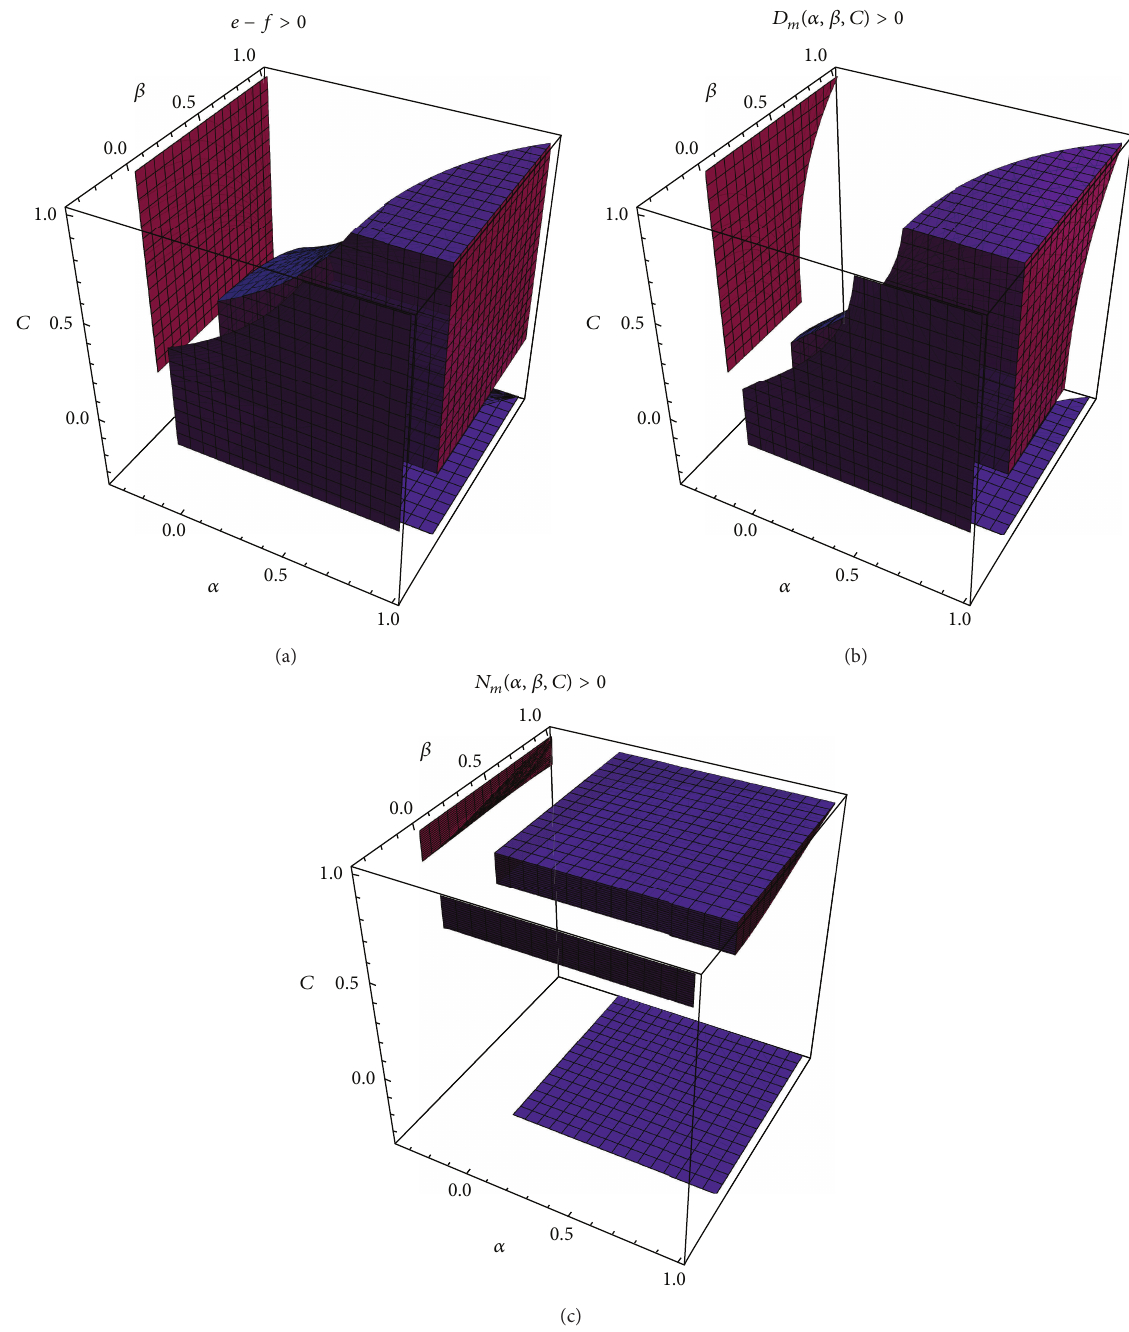
Figure 4: (a) (𝑒 − 𝑓)(𝛼,𝛽,𝐶) > 0 (colored). (b) 𝐷 𝑚 (𝛼,𝛽, 𝐶) > 0 (colored). (c) 𝑁 𝑚 (𝛼,𝛽, 𝐶) > 0 (colored).